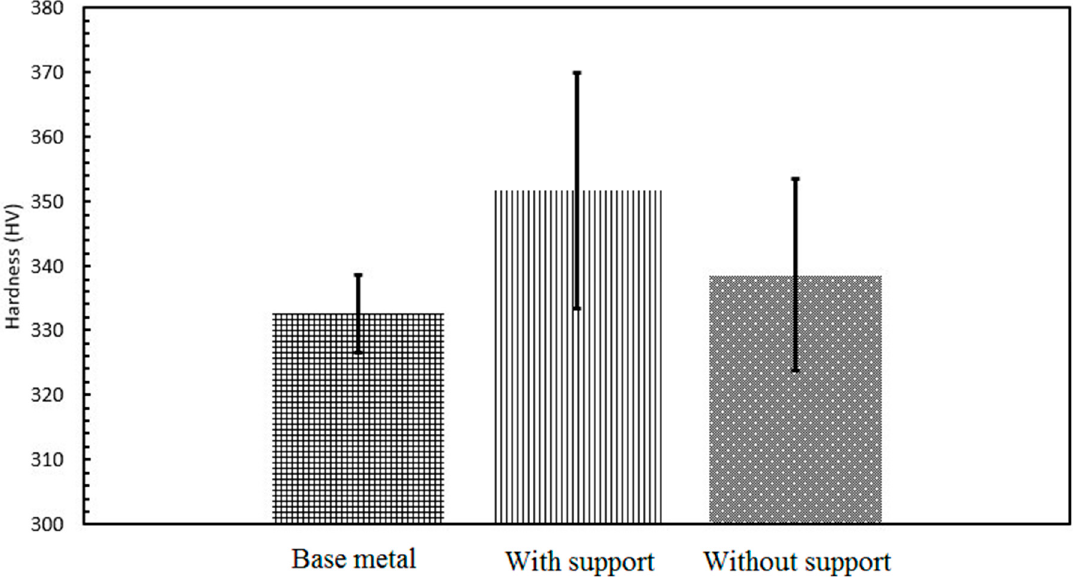
Figure 21. 17-mm-diameter and 5-mm-thick samples.